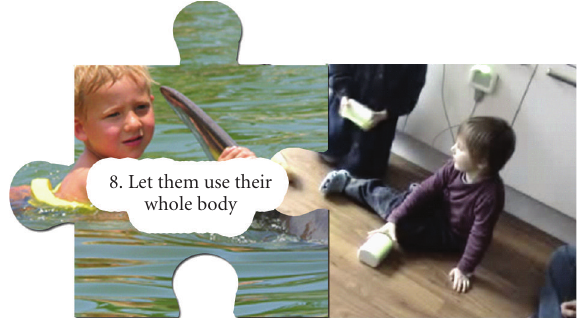
Figure 12: Whole body: (a) Beer swims with a dolphin in Florida. (b) Jakob plays with LINKX on the kitchen floor together with his